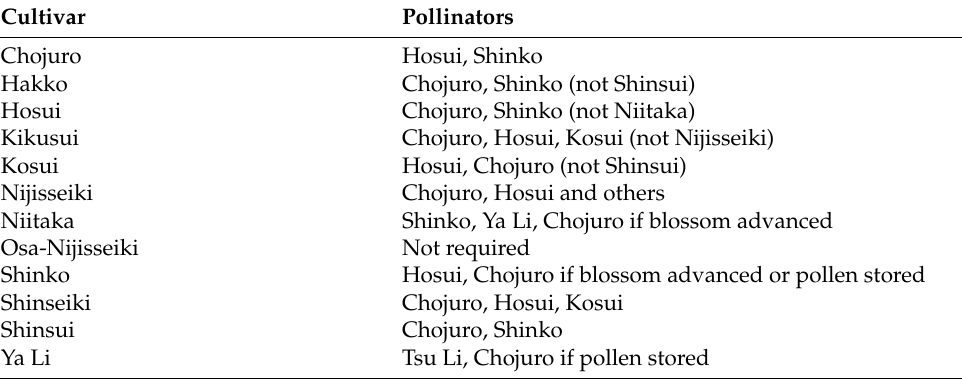
Table 4. Pollinator combinations for nashi recommended by MAFF Japan (summarised from Johnson